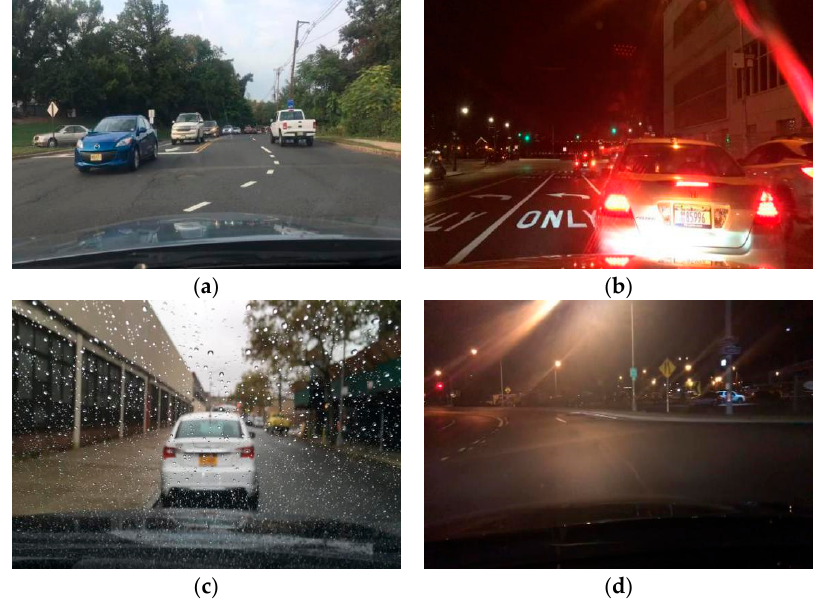
Figure 1. Examples of pictures of various weather and temporal conditions in the BDD100k dataset: ( a ) sunny weather; ( b ) night time; ( c ) rainy weather; and ( d ) foggy weather.